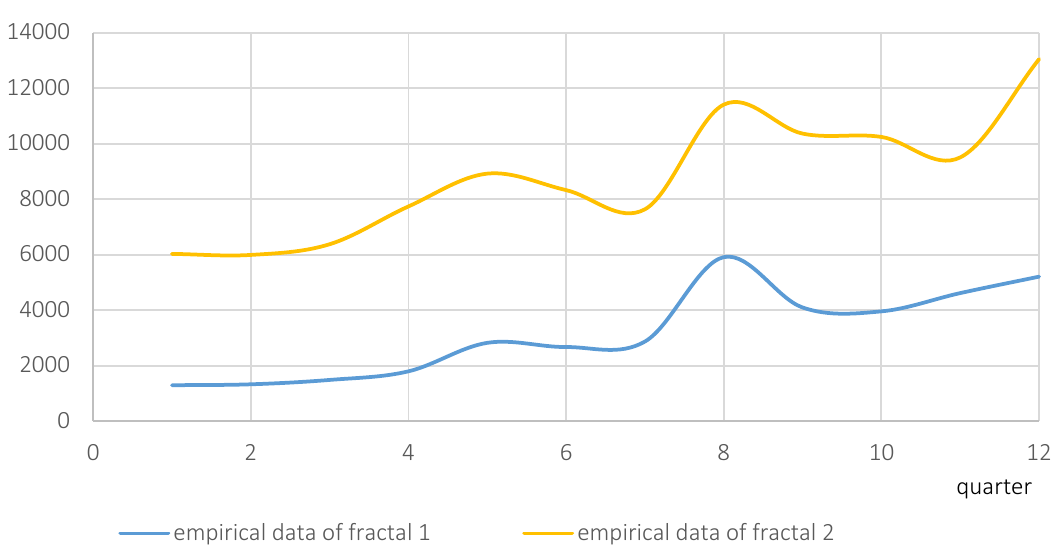
Figure 2. Dynamics of the volume of insurance payments in the Ukrainian insurance market